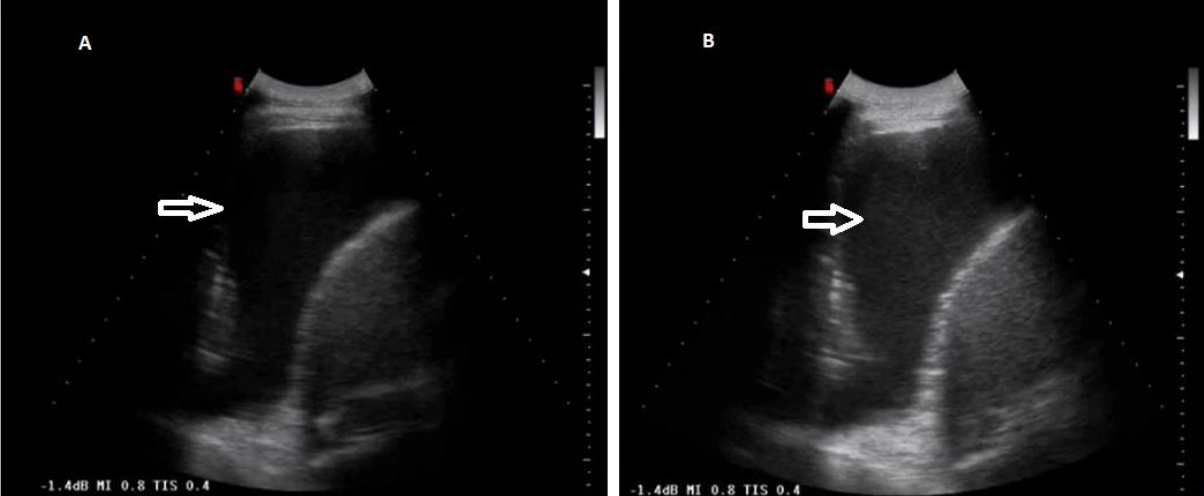
Figure 6. Gain variation on the same TUS scan. ( A ) Anechoic pleural effusion with correct gain setting. ( B ) Falsely hyperechoic pleural effusion due to improper gain increase.